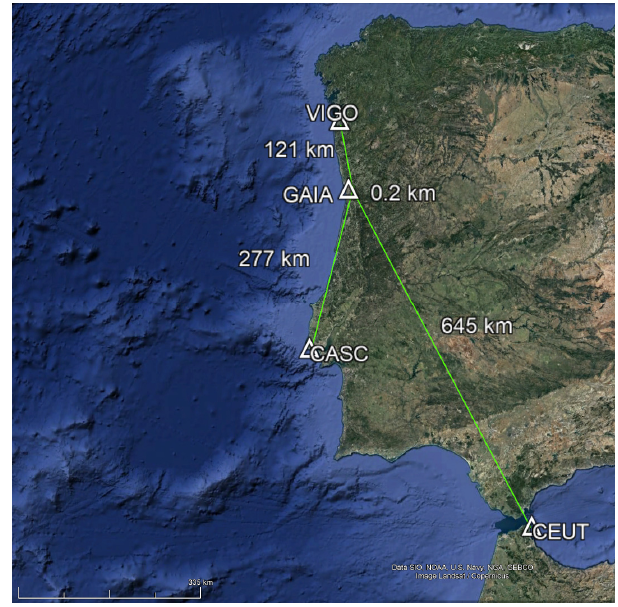
Figure 2. CORS baselines lengths.